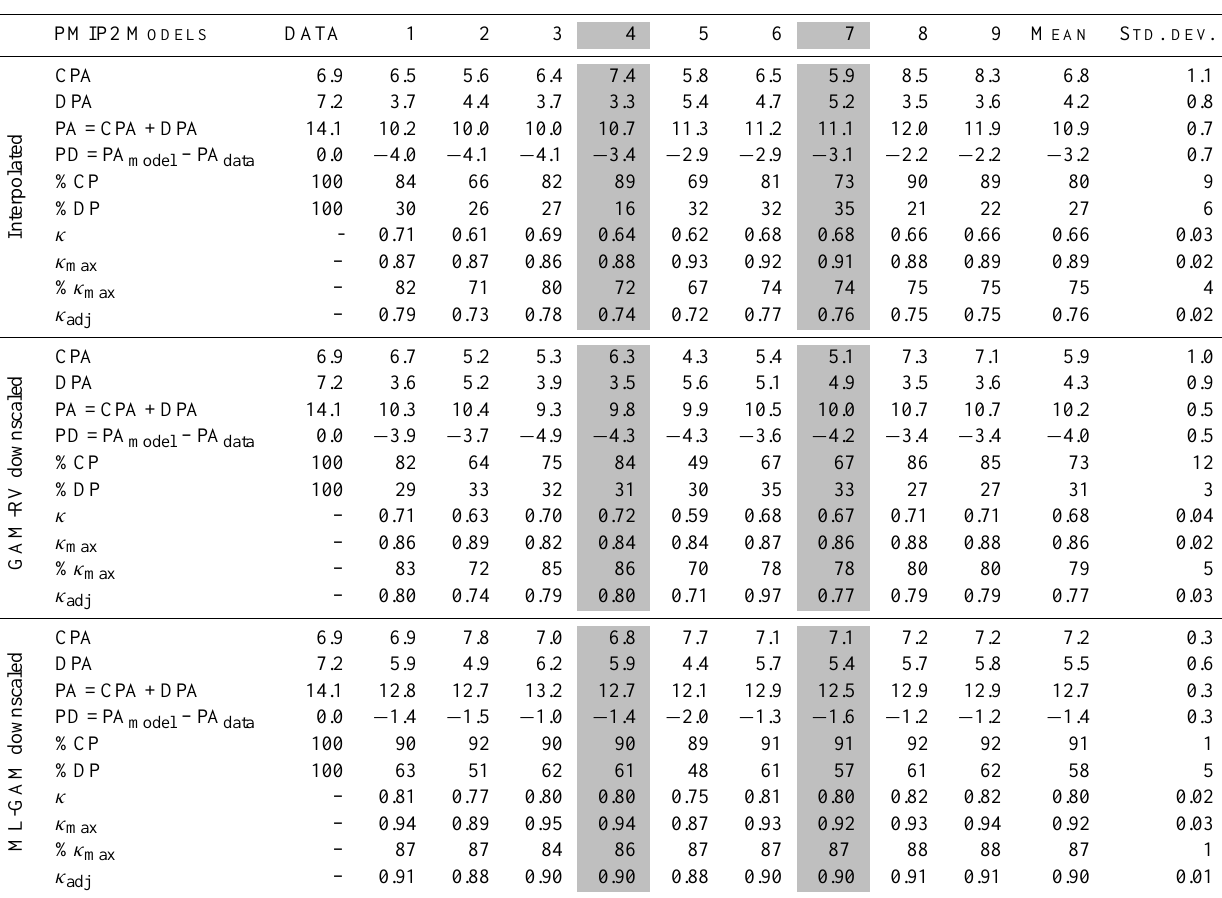
Table 2. PMIP2 quantitative results for CTRL period. “DATA” column corresponds to IPA/FGDC permafrost index. The CPA, DPA, PA, and PD indices are respectively set for continuous, discontinuous, total permafrost areas and total permafrost difference with data and are expressed in 10 6 km 2 . The %CP and %DP indices are respectively the percentages of continuous and discontinuous permafrost in agreement with data. The κ , κ max , κ adj indices corresponds respectively to the κ coefficient, its maximum value and its adjusted value. The % κ max is the percentage of κ max reached by κ . Numbers from 1 to 9 correspond to the PMIP2 models referenced in Table 1 with ECHAM5 (n ◦ 4) and IPSL-CM4 (n ◦ 7) models shaded in grey. Mean and standard deviation are computed with the nine climate models. For detailed explanation see text 4.1 and